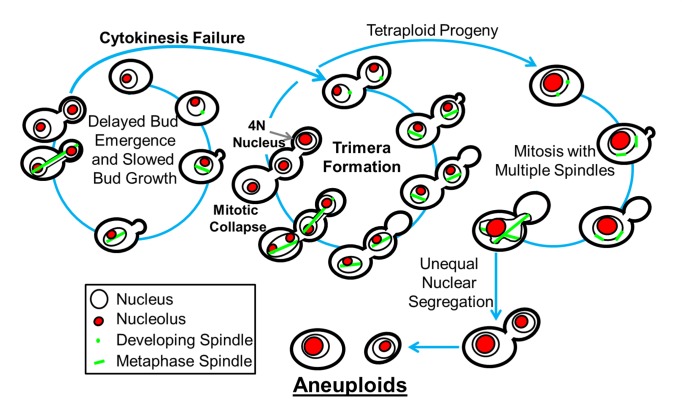
A model for aneuploid formation in C. albicans cells exposed to FLC.Proposed model for aneuploid formation in C. albicans cells exposed to FLC. Nuclear membrane, thin black line; nucleolus, red; spindle, green.